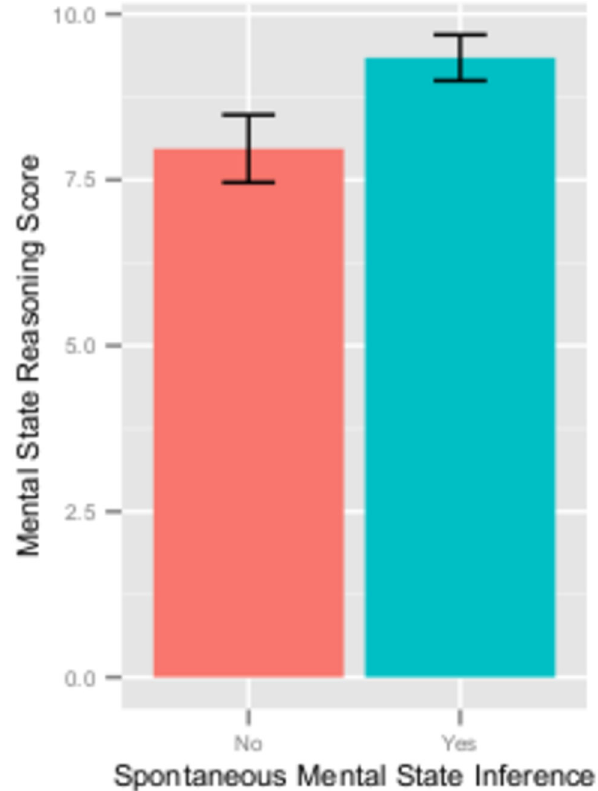
Figure 2. Mental state reasoning score as a function of spontaneous mental state inference. Mean mental state reasoning score of individuals who did (turquoise-colored bar) and individuals who did not (salmon-colored bar) make a spontaneous mental state inference in the summary question. Error bars depict standard error of the mean.